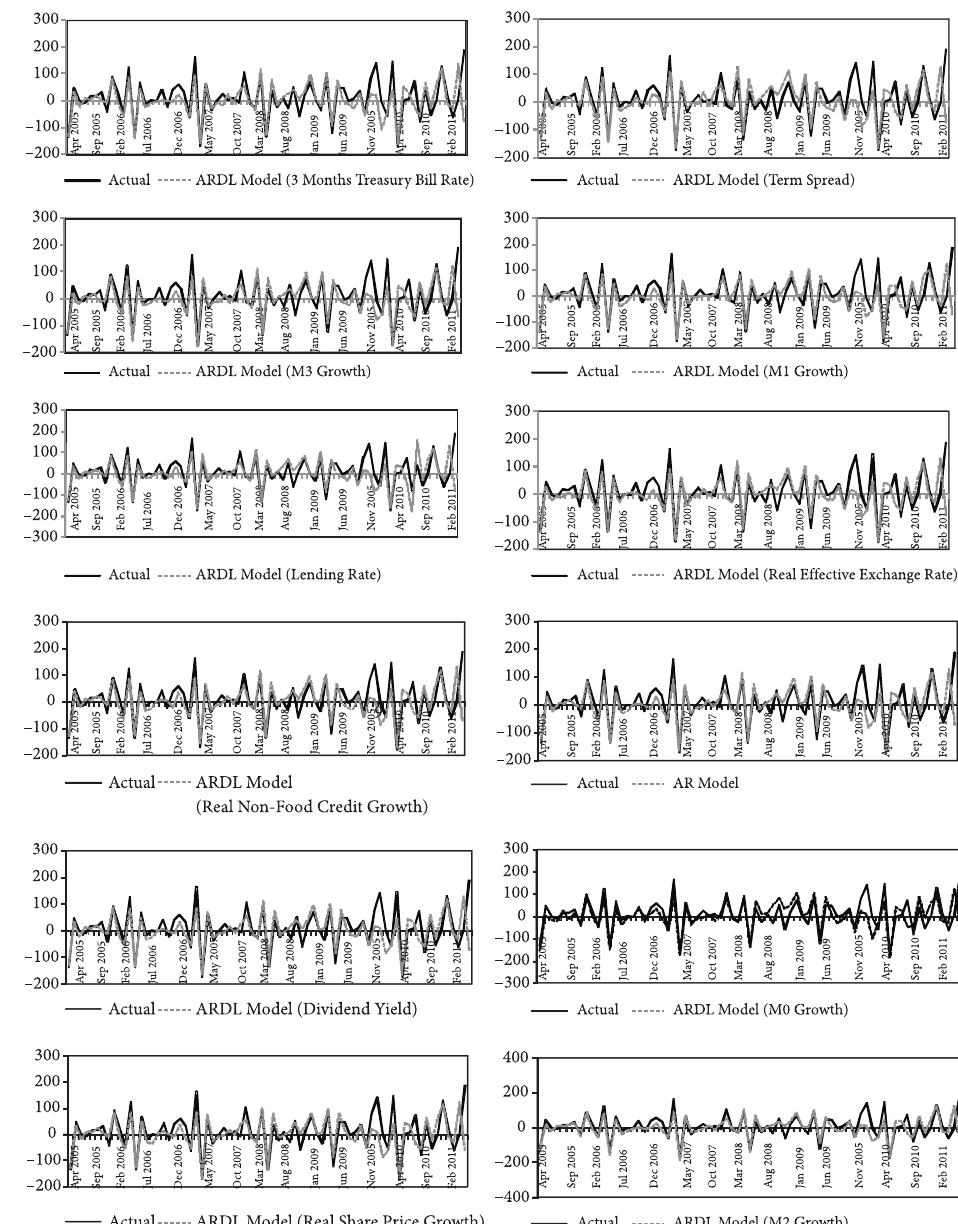
Fig. 2. out-of-sample one-step-ahead recursive forecast plots